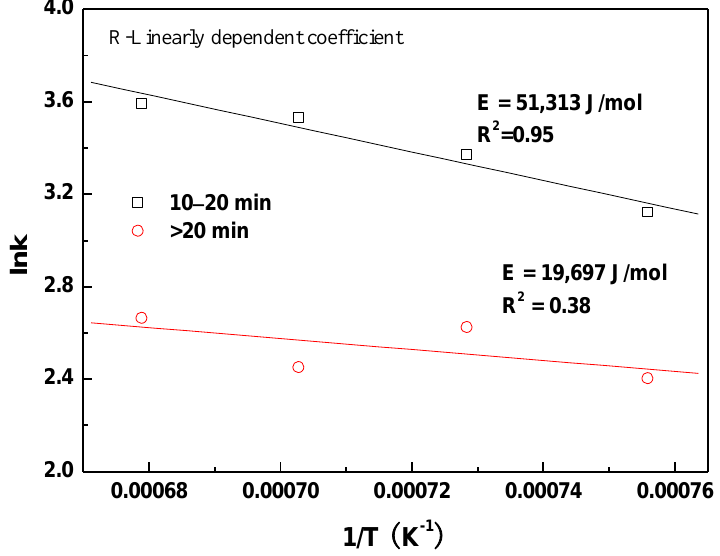
Figure 10. Arrhenius plot of the rate constant. E : the shrinkage apparent activation energy. Table 3. Coefficient factors ( a ( T )) for different temperatures and time ranges.